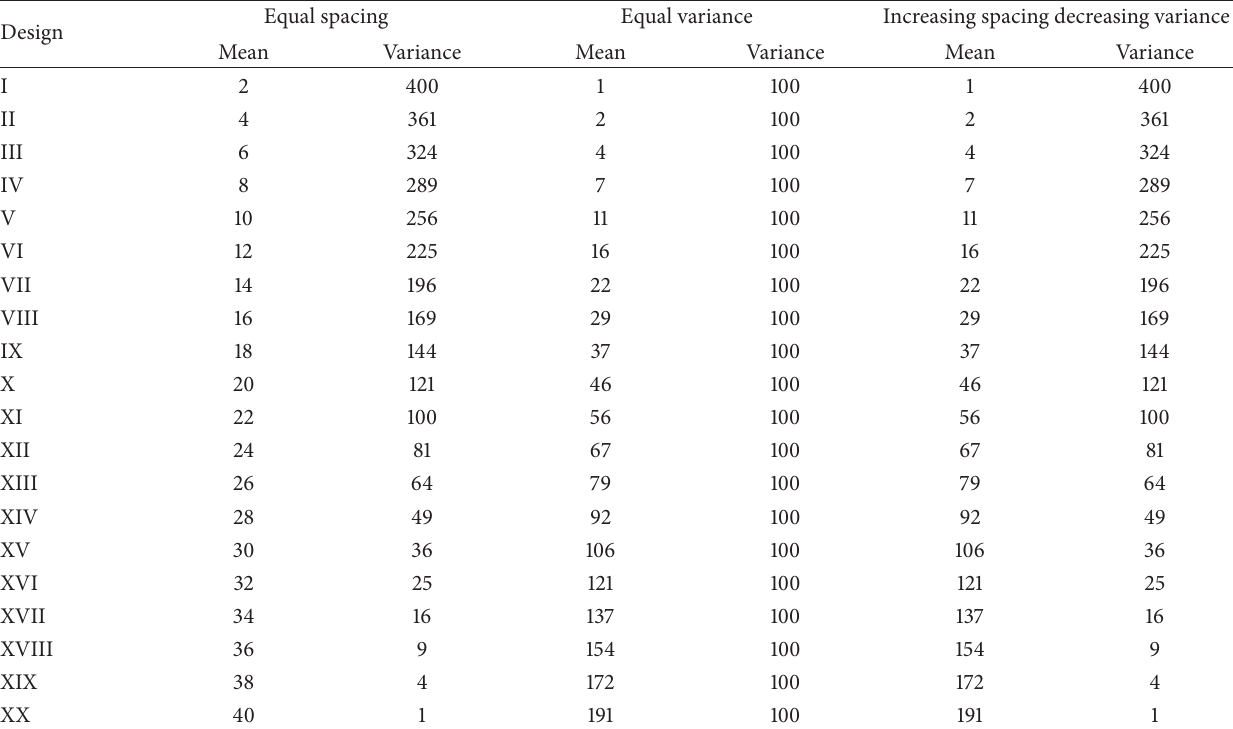
Table 1: Parameters for the numerical